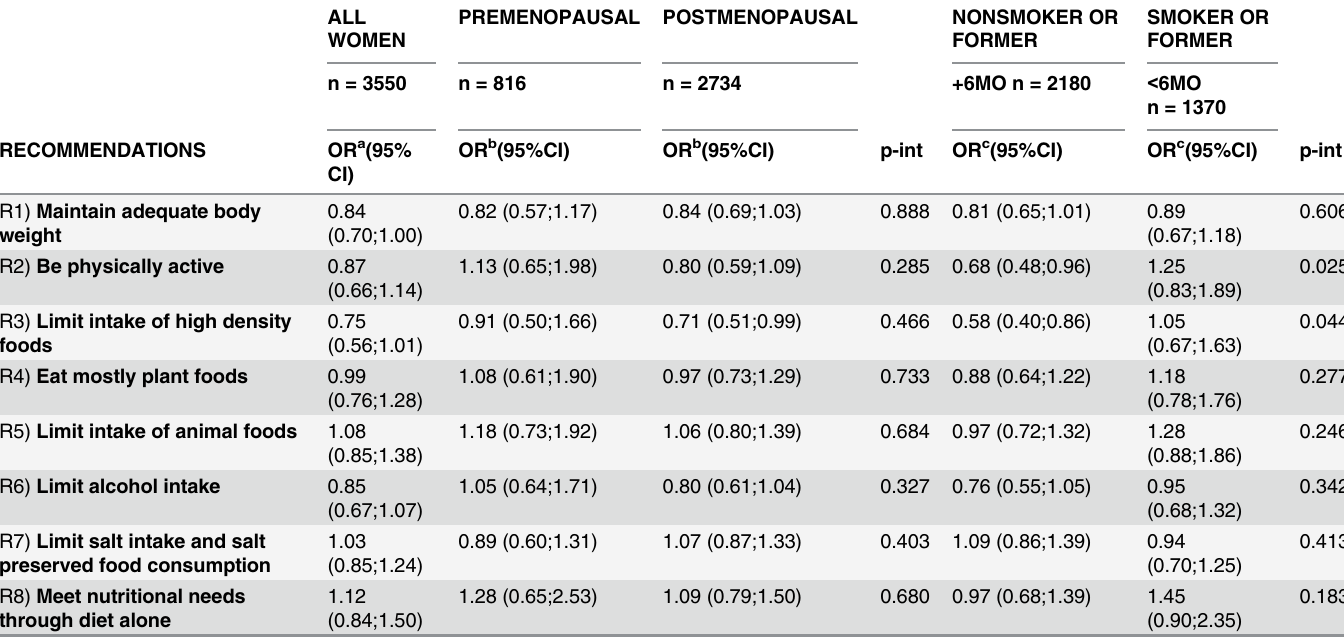
Table 4. Association between individual recommendations and MD in all women, by menopausal status and by smoking